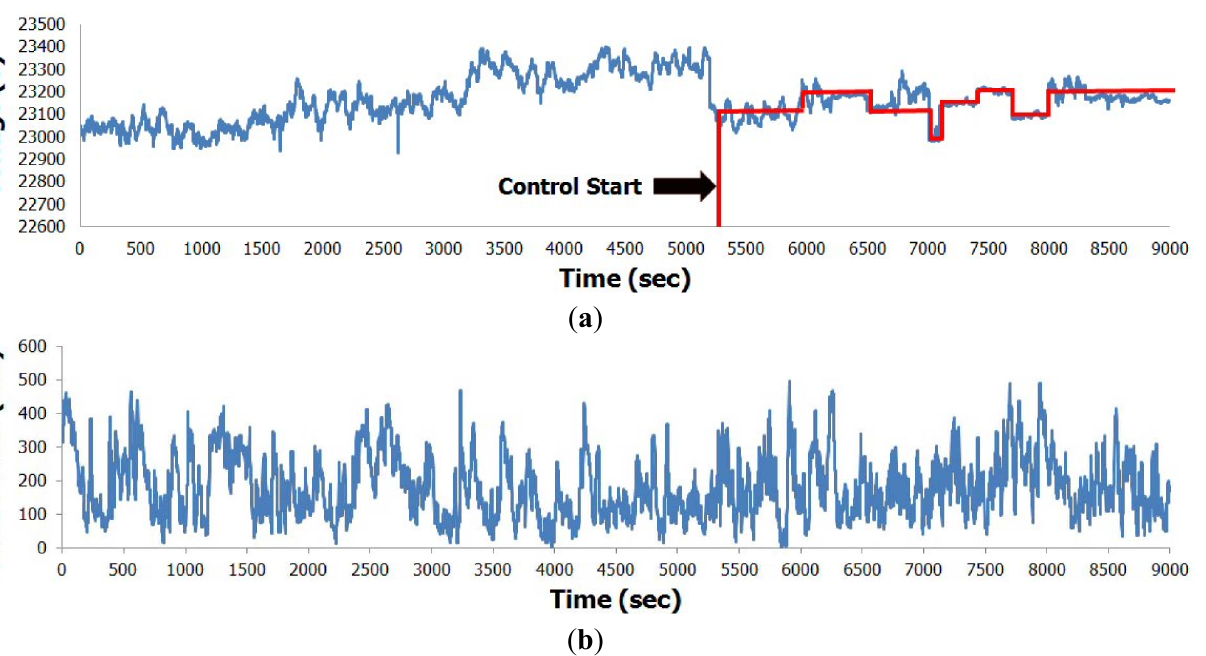
Figure 17. Test results of the voltage control using VVO: ( a ) voltage control using VVO for HW13 switch of Figure 15 and ( b ) active power output of wind